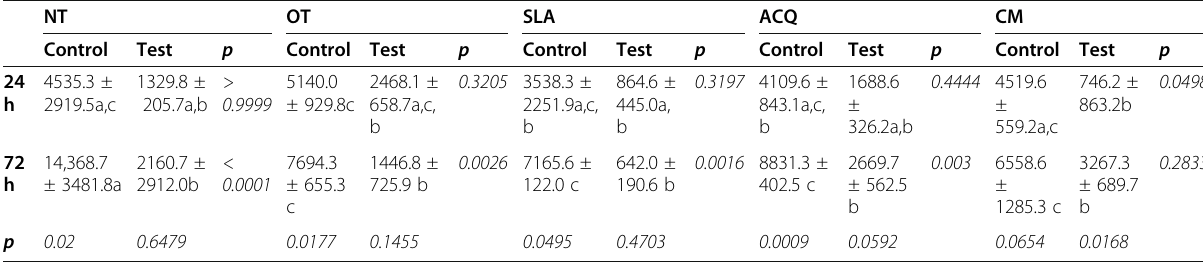
Table 3 Cell adhesion (24 h) and proliferation (72 h) on implant surfaces (mean ±